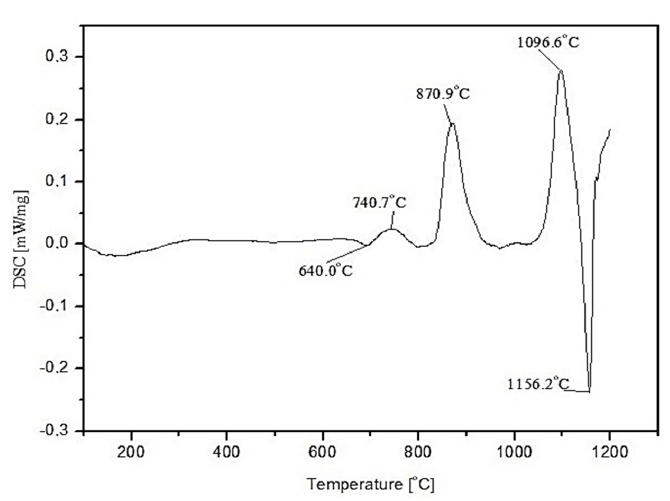
Figure 5. DSC curve of amphibolite glass with 10 wt.% dolomite addition (Set 2*).